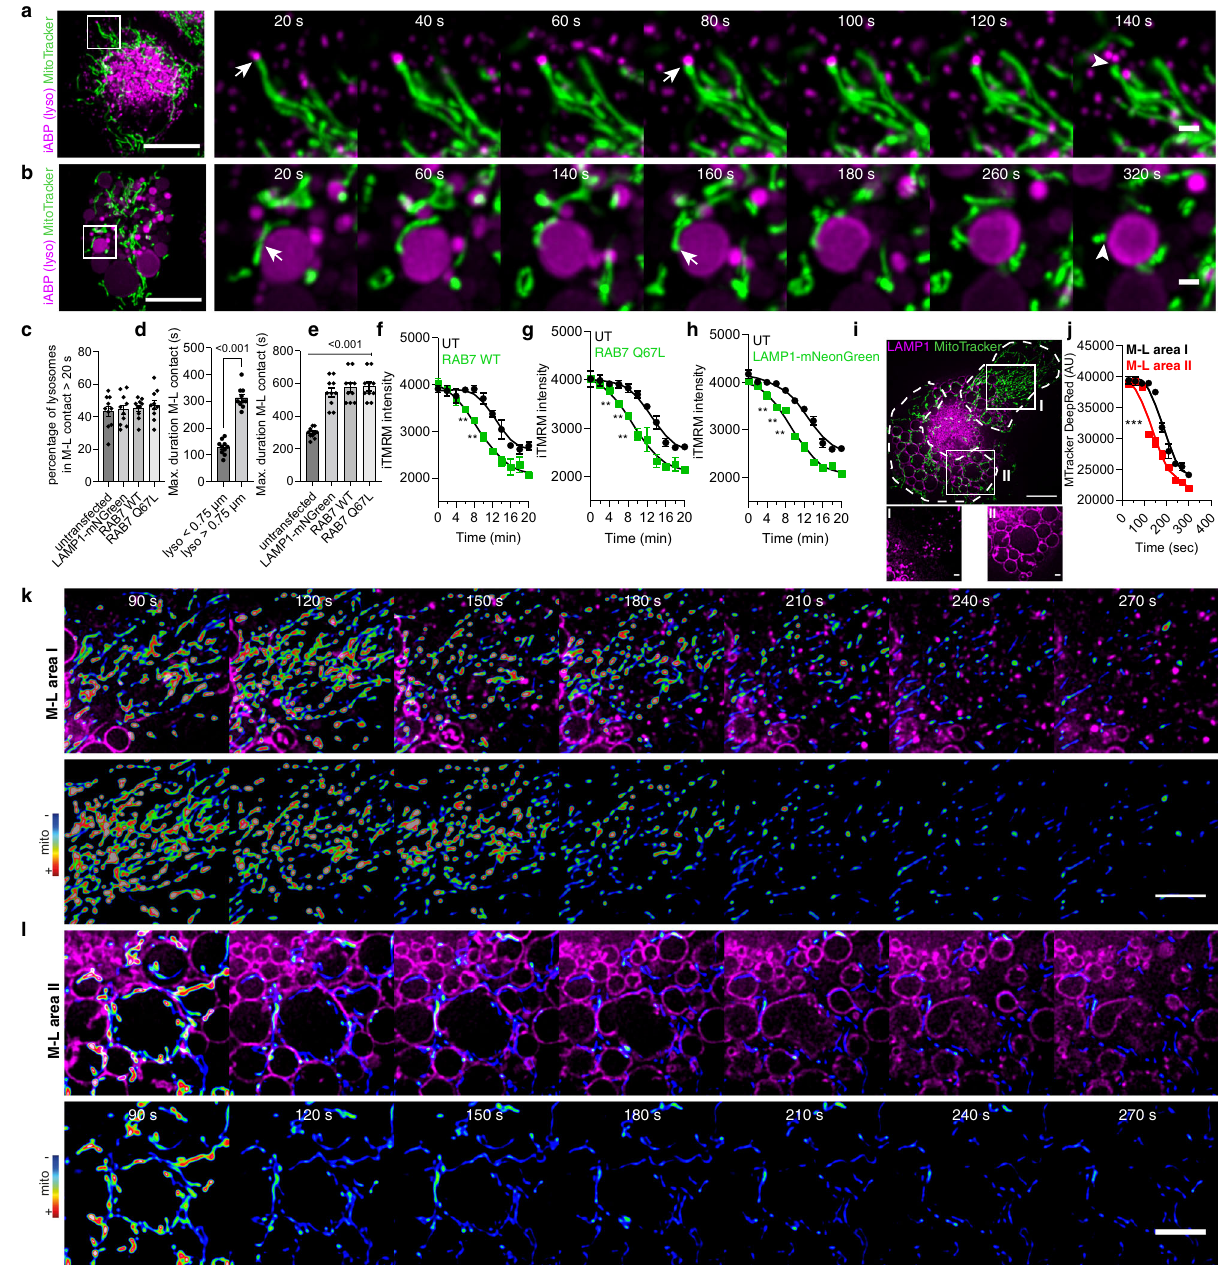
Fig. 4 | Proteases leakage from damaged lysosomes in the proximity of mito- chondria affects mitochondrial activity. a , b Live-cell super-resolution imaging (20s time frame) of iPSDM incubated with MitoTracker Green and with the iABP probeshowingsequencesfollowingasmall( a )andalarge( b )lysosome.Scalebars: 10 μ m and 1 μ m for images and zoom-in, respectively, (see Supplementary Movie 1 – 2). c – e Quanti fi cation from the datasets described above and in Supple- mentary Fig. 4 showing the percentage of lysosomes in contact with a mitochon- drion longer than 20s ( c ), the maximum duration of M-L contact in untransfected iPSDM considering lysosomes smaller than0.75 μ m and larger than 0.75 μ m ( d ) or comparing untransfected iPSDM with iPSDM transiently expressing the indicated plasmids ( e ). Data represent the mean ±SEM of at least 10 cells from one out of three independent experiments. f – h High content single cell evaluation of iTMRM intensity over time comparing untransfected iPSDM with iPSDM transiently